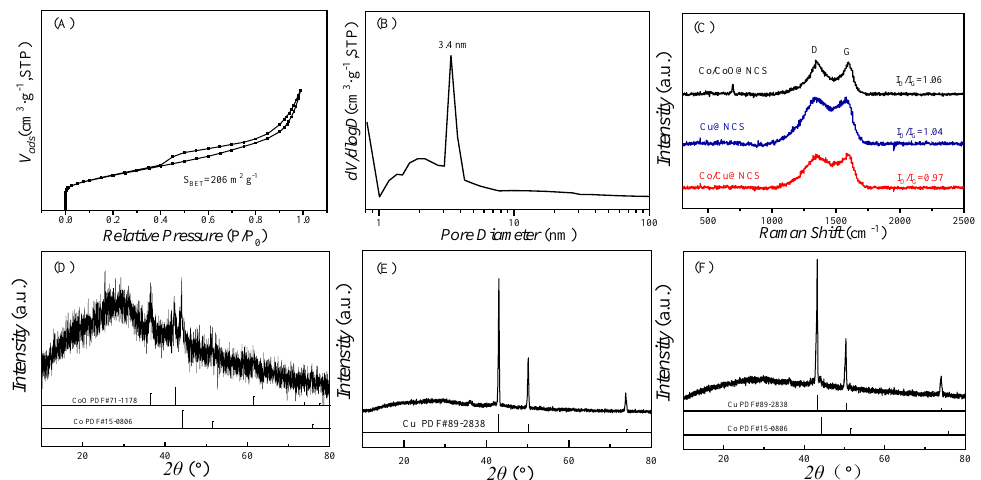
Figure 2. ( A , B ) Nitrogen adsorption–desorption isotherm and pore distribution curve of Co/CoO@NCS, ( C ) Raman spectra, and ( D – F ) XRD patterns of Co/CoO@NCS, Cu@NCS, and Co/Cu@NCS.